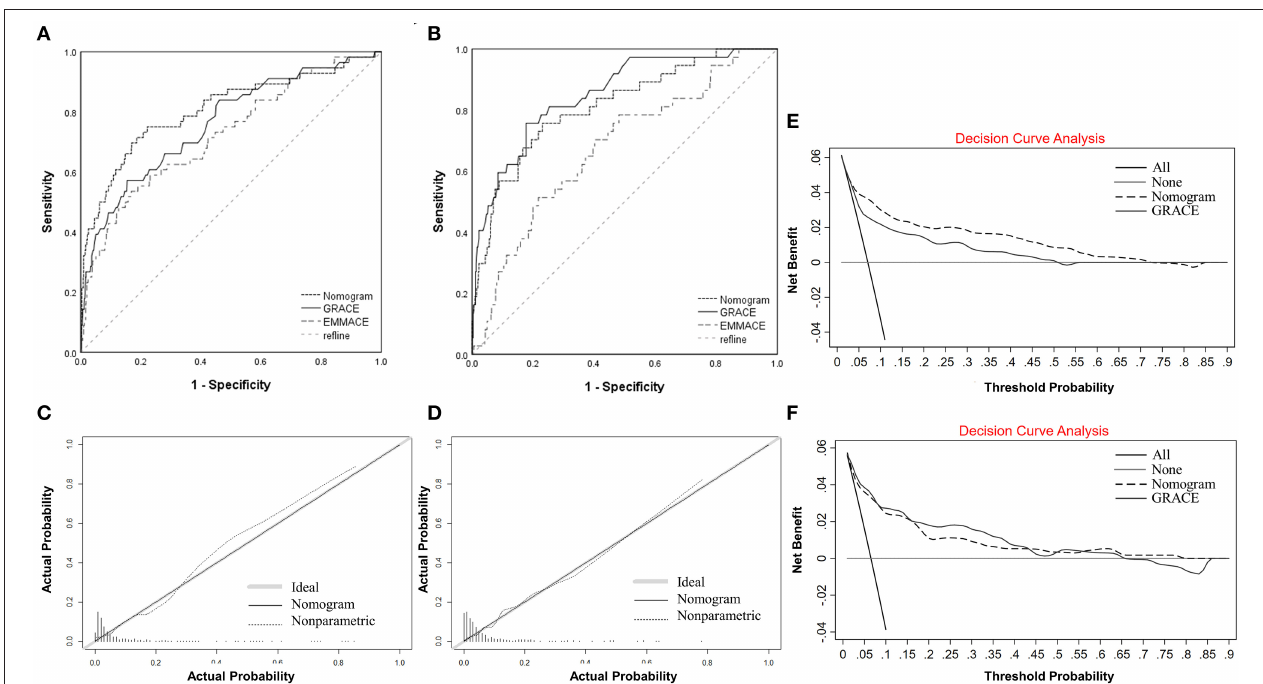
FIGURE 4 | Comparison of ROC curves for nomogram with GRACE score and EMMACE score for predicting in-hospital MACCE in patients with ACS in the training cohort. (A) Comparison of ROC curves for the in-hospital MACCE nomogram with GRACE score and EMMACE score in the training cohort. (B) Comparison of ROC curves for the in-hospital MACCE nomogram with GRACE score and EMMACE score in the validation cohort. (C) Calibration plot of the in-hospital MACCE nomogram in the training cohort. (D) Calibration plot of the in-hospital MACCE nomogram prediction in the validation cohort. The x-axis represents the predicted in-hospital MACCE risk in ACS. The y-axis represents the actual diagnosed in-hospital MACCE. The diagonal line represents a perfect prediction by an ideal model. The solid line represents the performance of the nomogram, in which a closer fit to the diagonal line represents a better prediction. (E) Decision curve analysis for the in-hospital MACCE nomogram and GRACE score in the training cohort. (F) Decision curve analysis for the in-hospital MACCE nomogram and GRACE score in the validation cohort. The y-axis measures the net benefit. The black dotted line represents the in-hospital MACCE nomogram and the black zone line represents the GRACE score. The gray solid line represents the assumption that all patients are ACS complicated with MACCE. The black solid line represents the assumption that none of the patients used MACCE in ACS. The decision curve analysis showed that if the threshold probability of a patient is between 2 and 80%, using this in-hospital MACCE nomogram prediction in the current study to predict in-hospital MACCE risk adds more benefit than the “intervention-for-all” patient scheme or the “intervention-for-none”. ACS, acute coronary syndrome; EMMACE, Evaluation of the Methods and Management of Acute Coronary Events; GRACE, Global Registry of Acute Coronary Events; MACCE, major adverse cardiovascular and cerebrovascular events; ROC, receiver operating